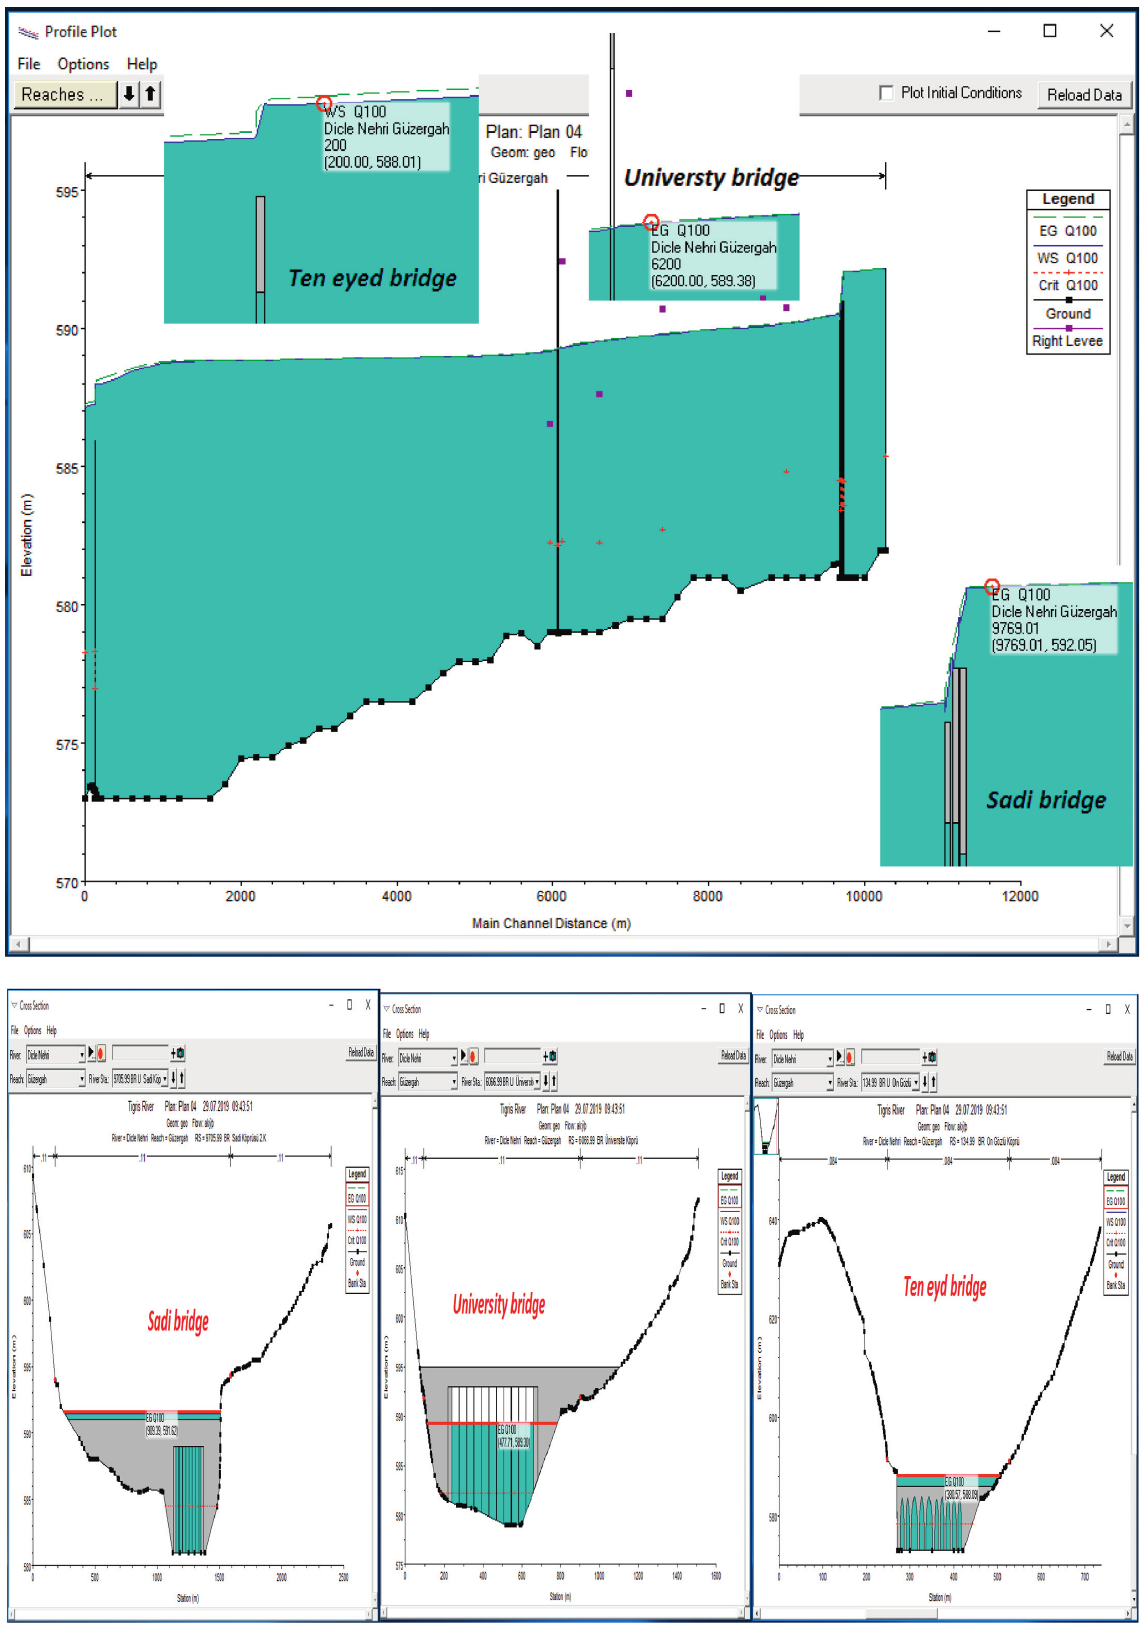
Figure 9: Water surface profiles for bridges ( Q